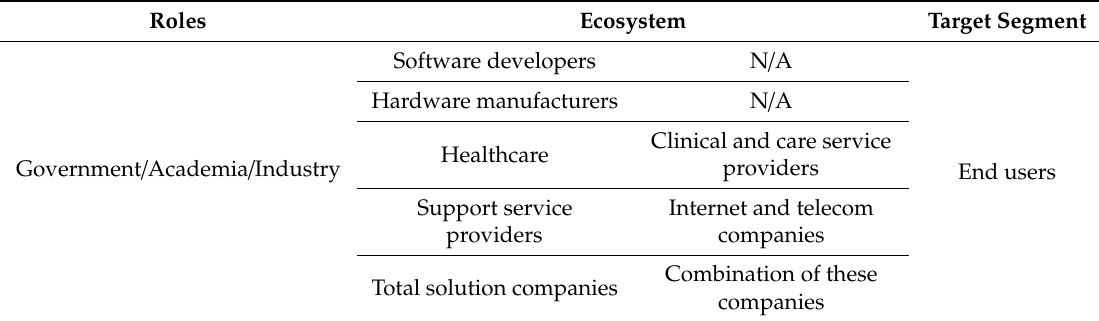
Table 1. Roles in connected health (CH) ecosystem (Source: [17] Edited by the author,